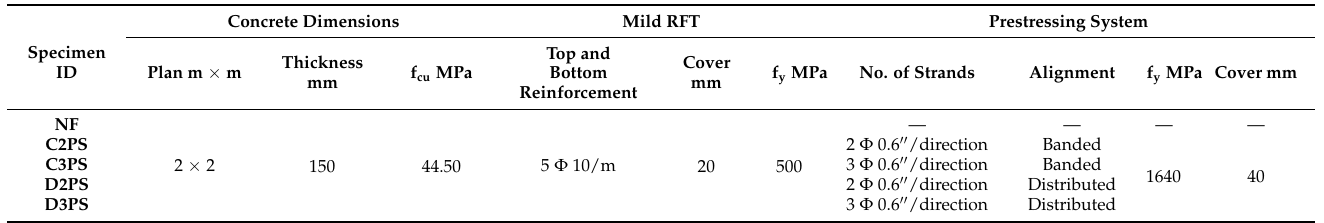
Table 1. Dimensions and properties of reinforced concrete, steel reinforcement and post-tensioing cables.